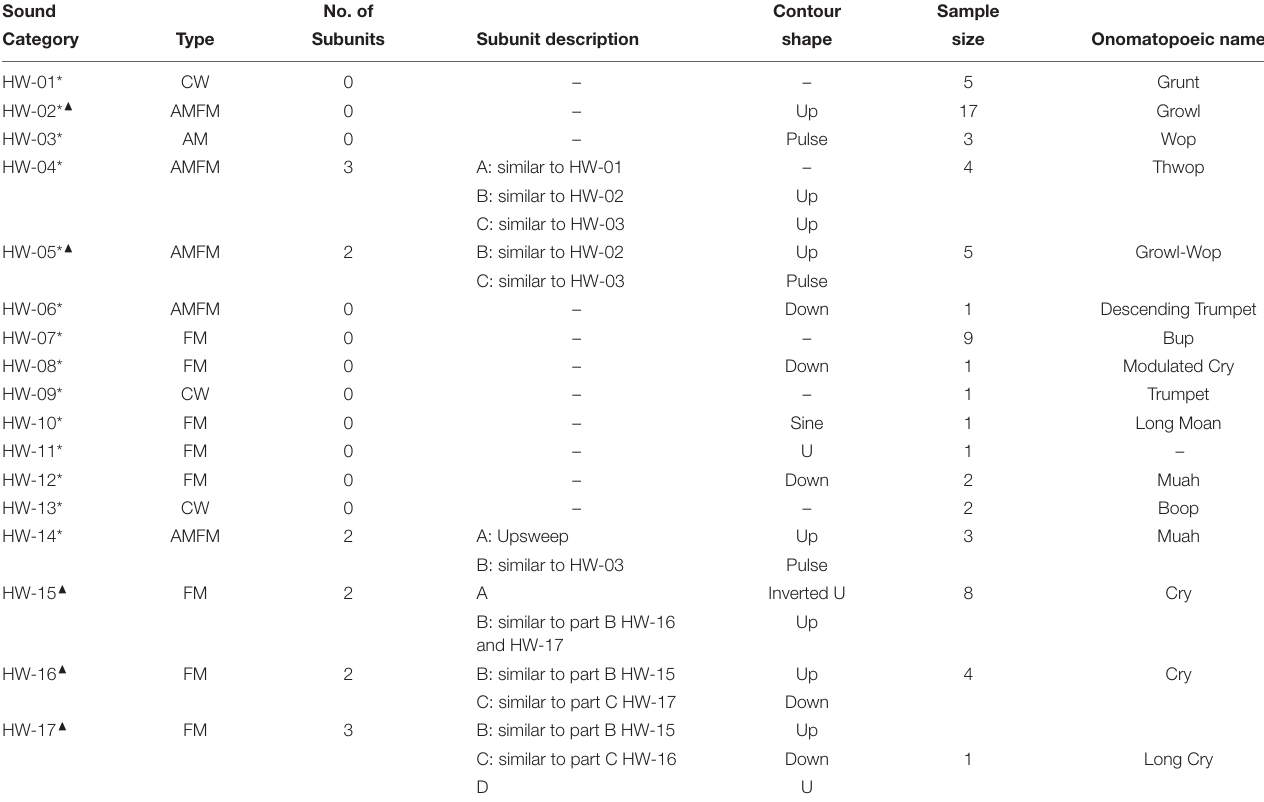
TABLE 3 | Summary of spectral features and onomatopoeic names for non-song sound types recorded in Geographe Bay and off Port Hedland.